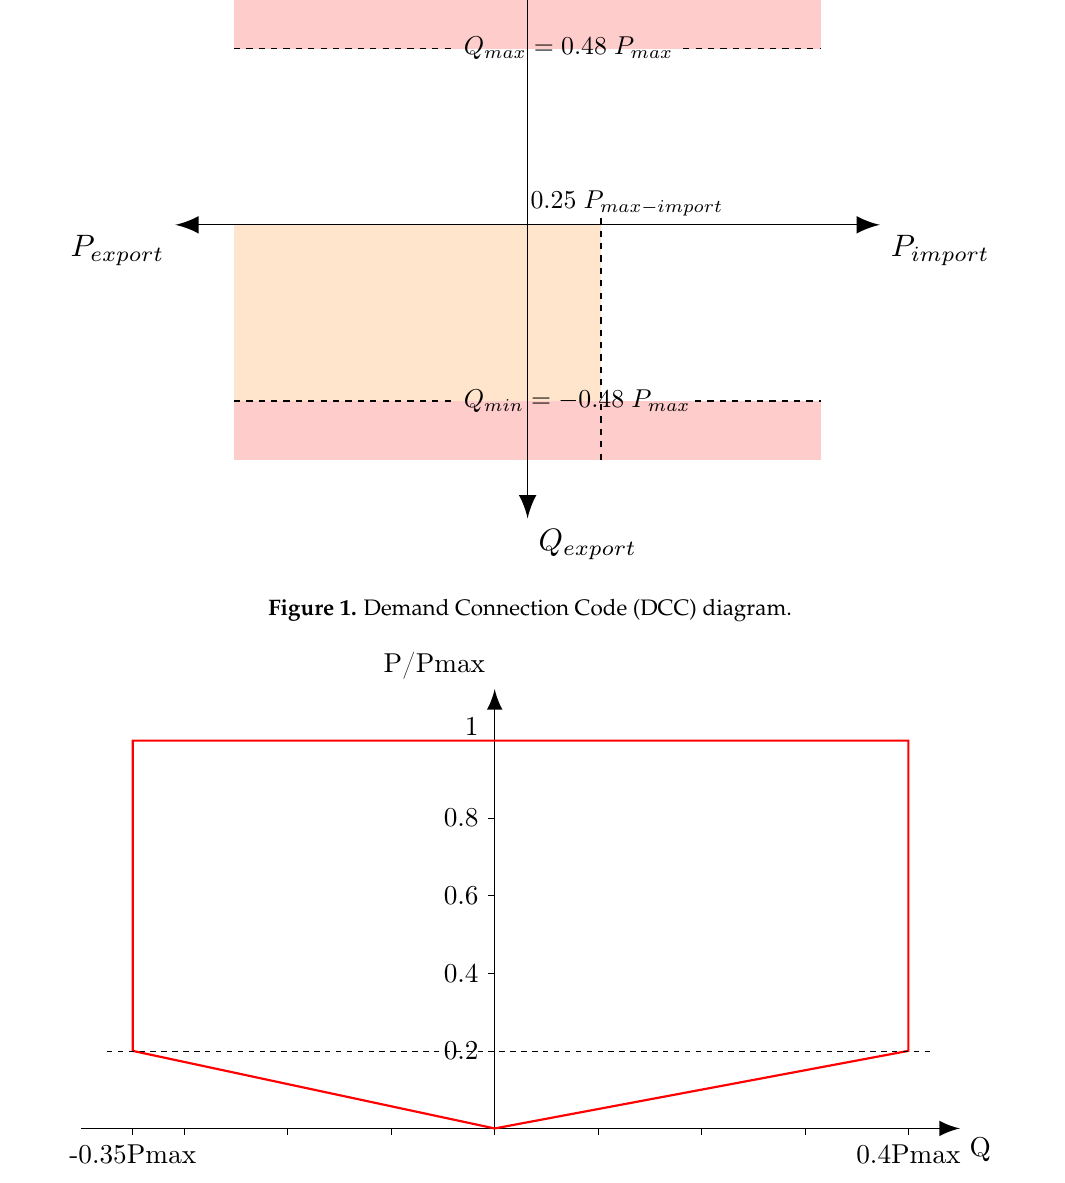
Figure 2. Distributed generators (DG) PQ